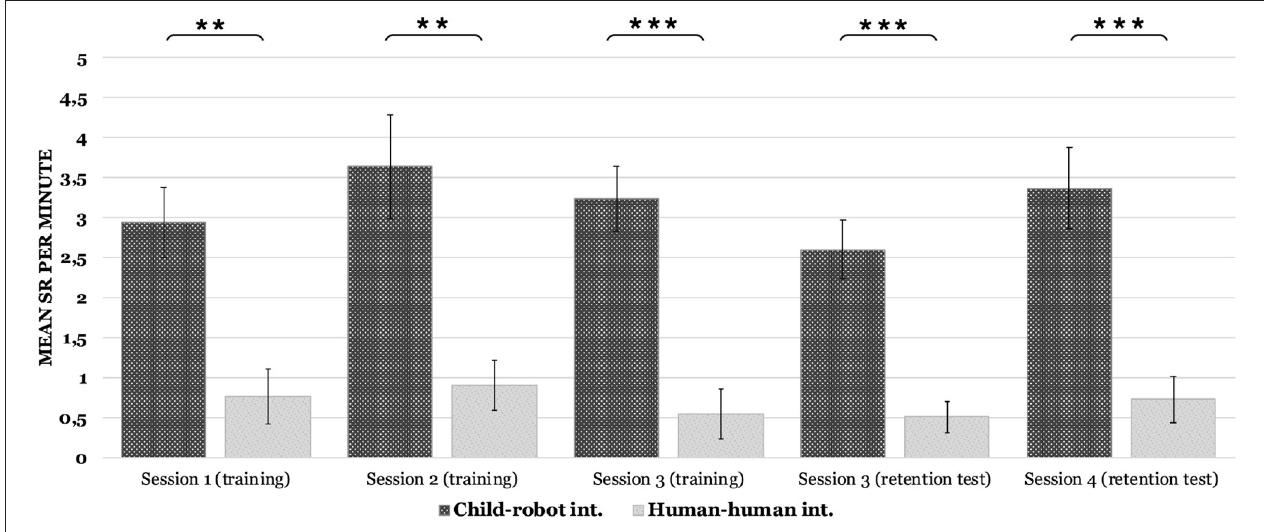
FIGURE 5 | Children’s social referencing (SR) per minute (** p < 0.01, *** p <